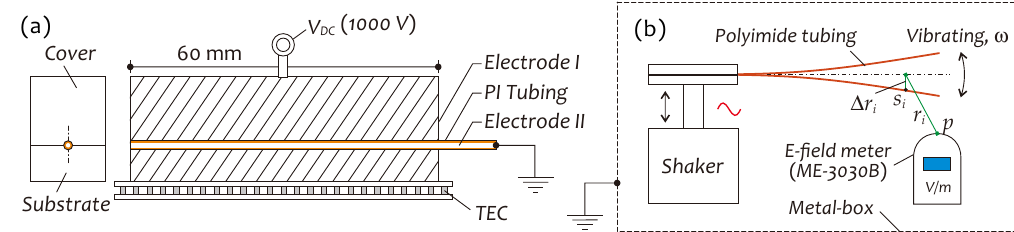
Figure 2. ( a ) A jig for PI tubing charging, ( b ) a setup for detecting charge field